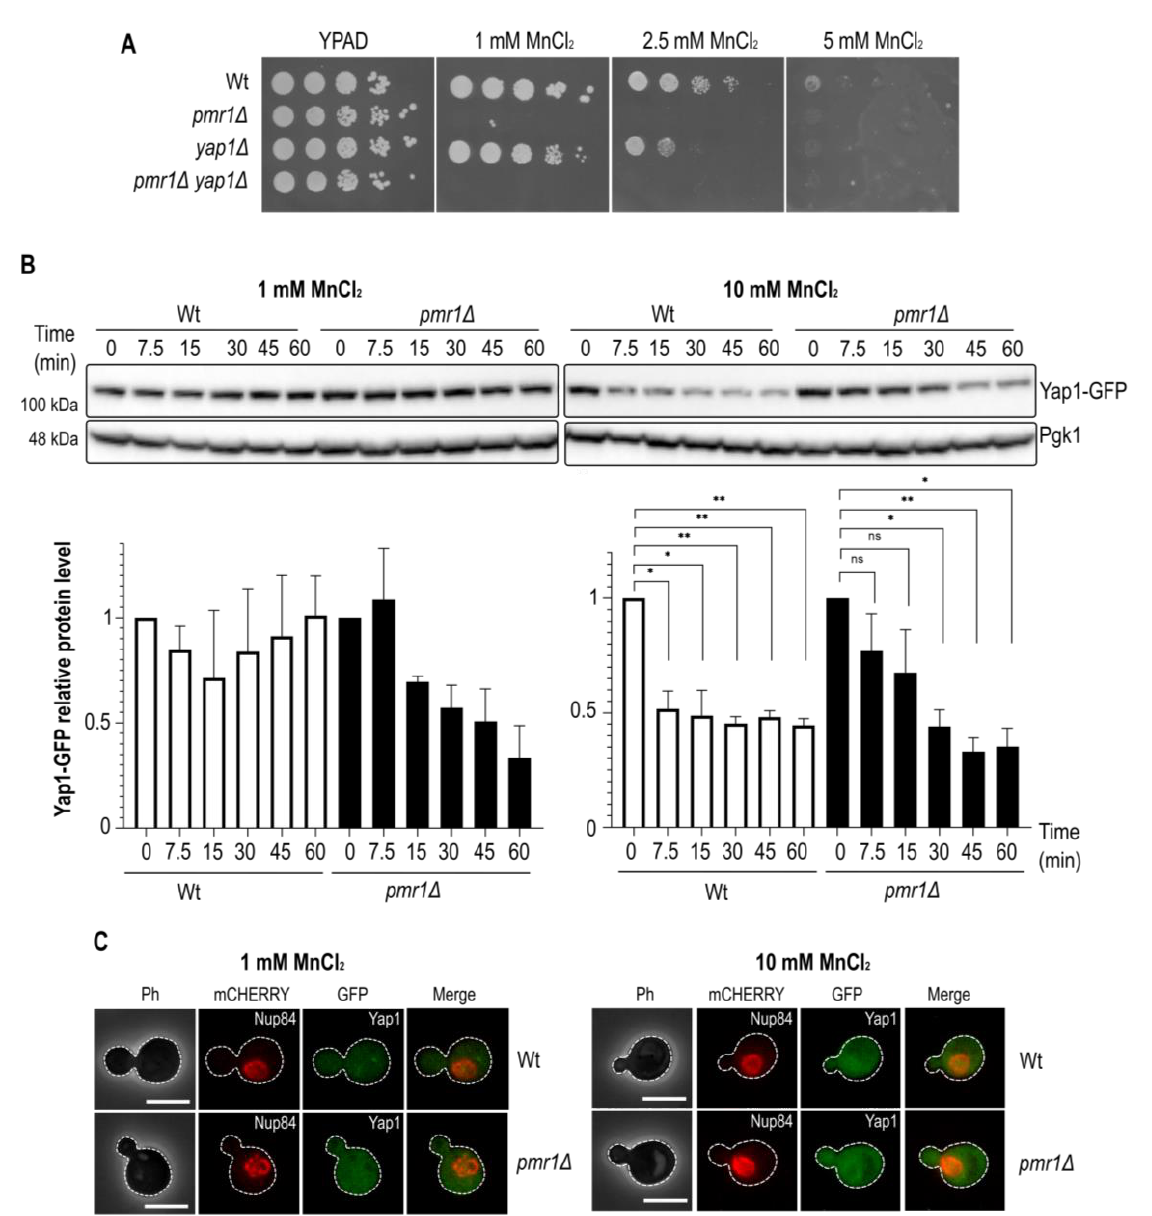
Figure 2. Yap1 is a target for manganese stress response. ( A ) Growth on MnCl 2 -containing medium. 10-fold dilutions of exponentially growing cells are shown. The strains and MnCl 2 concentrations are indicated. The pictures were taken after 3 days of growth. ( B ) Immunoblot of Yap1-GFP protein levels after MnCl 2 addition in Wt and pmr 1∆ mutants. MnCl 2 concentration and incubation times (min) prior to protein isolation are indicated. Pgk1 (3-phosphoglycerate kinase 1) protein levels, probed with anti-Pgk1 antibodies, served as a loading control. Quantification of Yap1 protein levels is shown below. SEM with bars and p -value are indicated ( p -value 0.05 *; 0.01 **). Time point 0 was set to 1. ( C ) Fluorescence microscopy analysis of Yap1-GFP localization. The cells were analyzed before and after 15 min treatment with 1 or 10 mM MnCl 2 . Nup84-mCherry was used as a nuclear marker. Scale bar represents 5 µm.